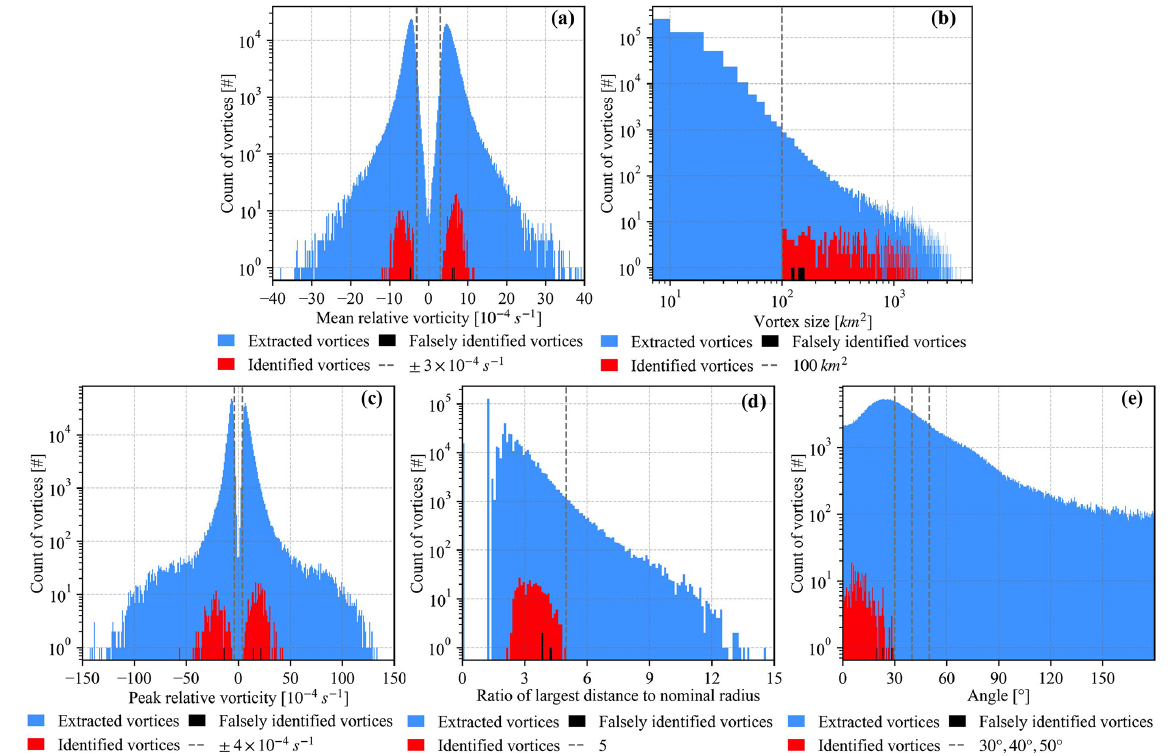
Figure B1. Histograms of vortex statistics including (a) mean relative vorticity, (b) vortex size, (c) peak relative vorticity, (d) the ratio of the largest distance within a vortex to its nominal radius and (e) deviation angles described in Sect. 2.4. The blue shadings represent extracted vortices using the first two steps of our algorithm, and the red (black) shadings represent the correctly (falsely) identified vortices using our algorithm during the case study